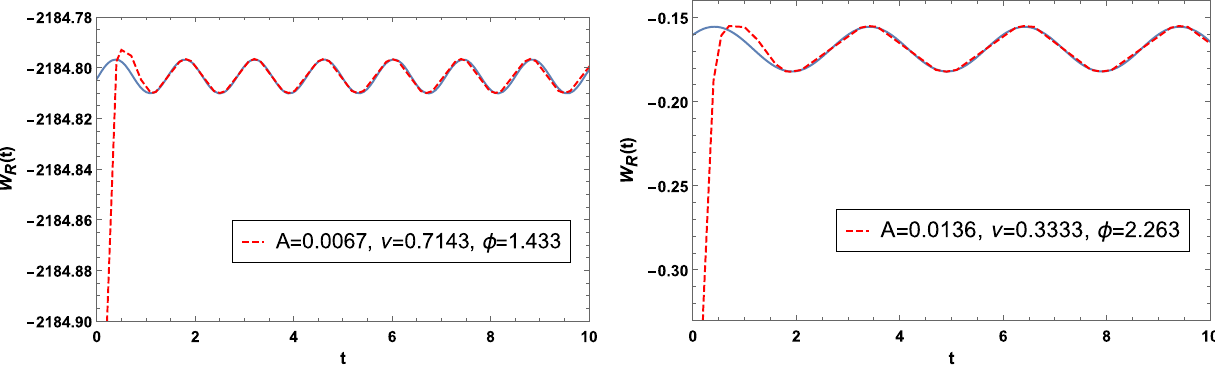
Fig. 2 W R ( t ) in terms of boundary time t for k = 0 . 3, μ f = 0 . 4503, T f = 0 . 1428 and μ f / T f = 3 . 15. The distance between the pair is l = 0 . 5 ( l = 1) for the left (right) graph. The static potential is